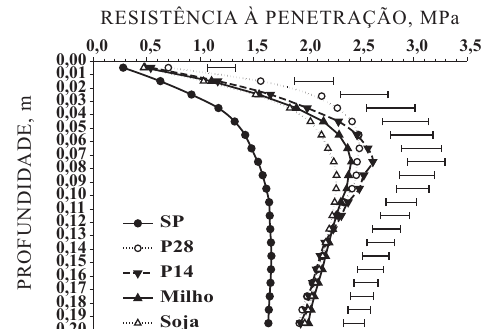
Figura 1. Resistência à penetração mecânica, avaliada por penetrômetro digital, de um Argissolo Vermelho-Amarelo alumínico em diferentes sistemas de manejo de uma pastagem de inverno (SP: sem pastejo; P28: pastejo a cada 28 dias; P14: pastejo a cada 14 dias). As barras horizontais correspondem à diferença mínima significativa apenas entre os sistemas de manejo das pastagens de inverno pelo teste de Tukey (p < 0,05). Diferenças entre espécies cultivadas de verão (milho e soja) não foram significativas pelo teste F (p < 0,05).